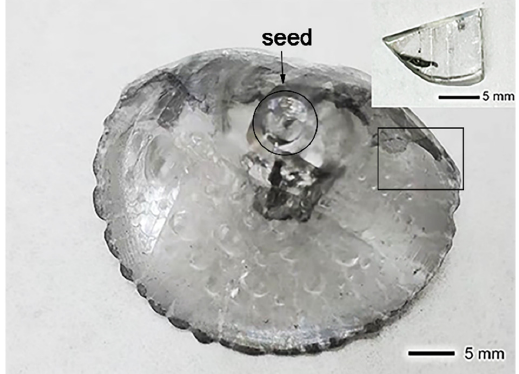
Figure 1. A photograph of a β -Ga 2 O 3 crystal containing the floating particles obtained using the CZ method. The inset shows the sample cut from the large β -Ga 2 O 3 crystal for characterization. The black rectangular and round boxes mark the positions of the sample and seed crystal in the single crystal, respectively.